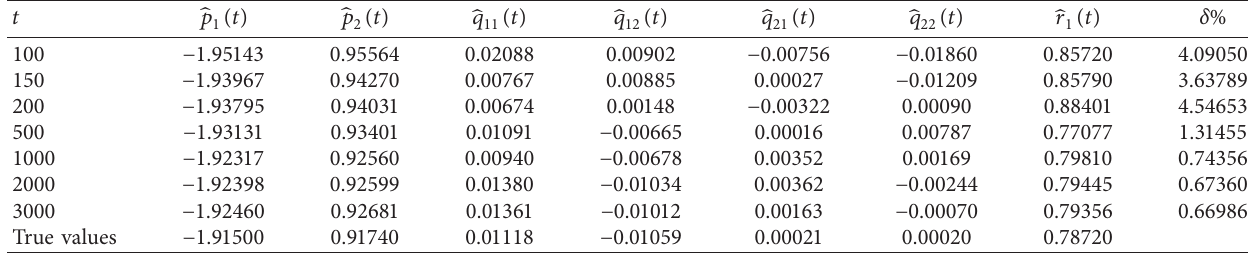
Table 3: The parameter estimates and their errors with clustering inputs based recursive least squares algorithm ( σ 2 � 0 . 10 2 ) .